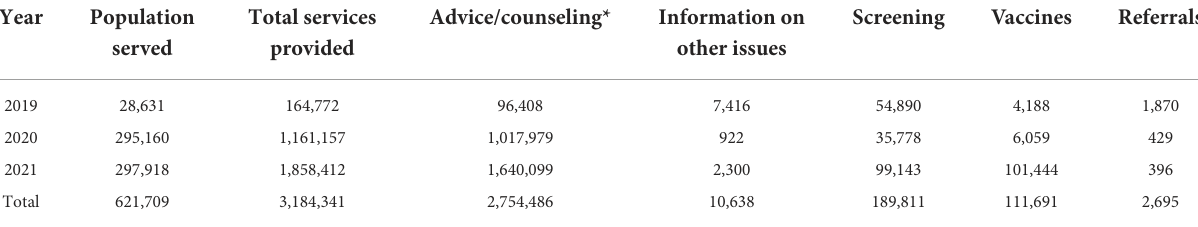
TABLE 2 Population served and services provided in MHU, January 2019—December 2021.